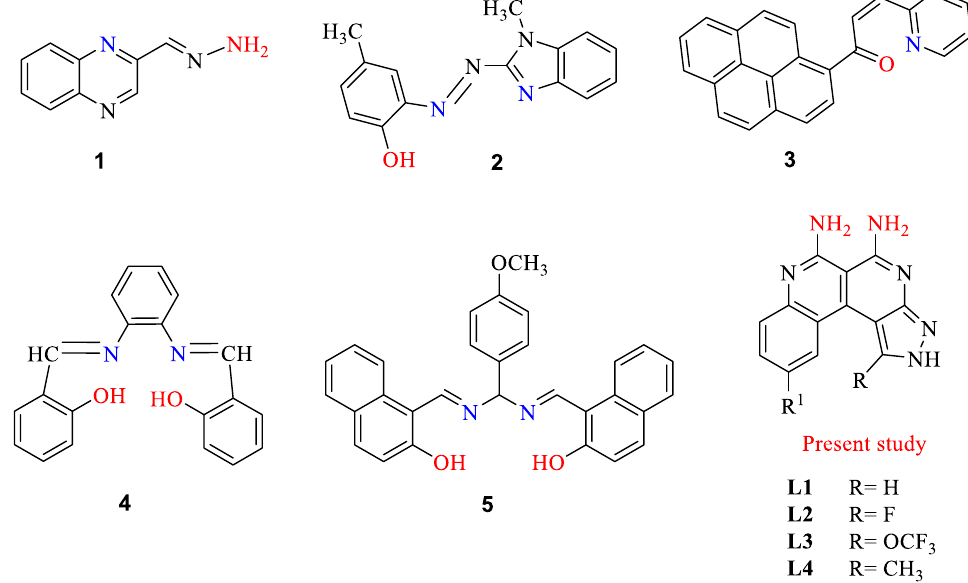
Figure 1. Some structural motifs employed in Nickel sensors, and L1-L4 from the present